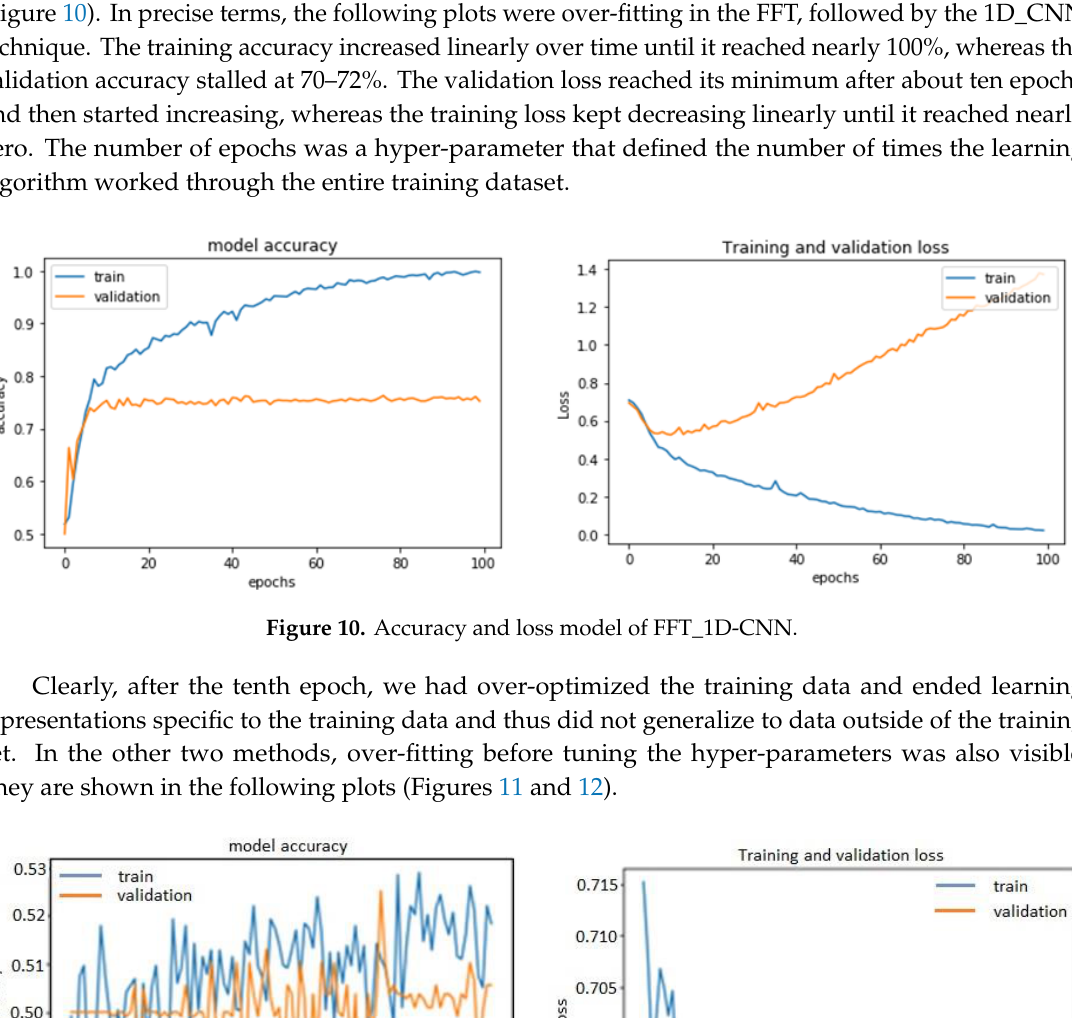
Figure 12. Accuracy and loss model of wavelet_1D-CNN. To find the optimal configuration, we needed to regularize the model and tune the hyper- parameters that neither under-fit nor over-fit. It was required to modify the model, train repeatedly, and evaluate the validation data (not the test data at this point). Several modification items were: •